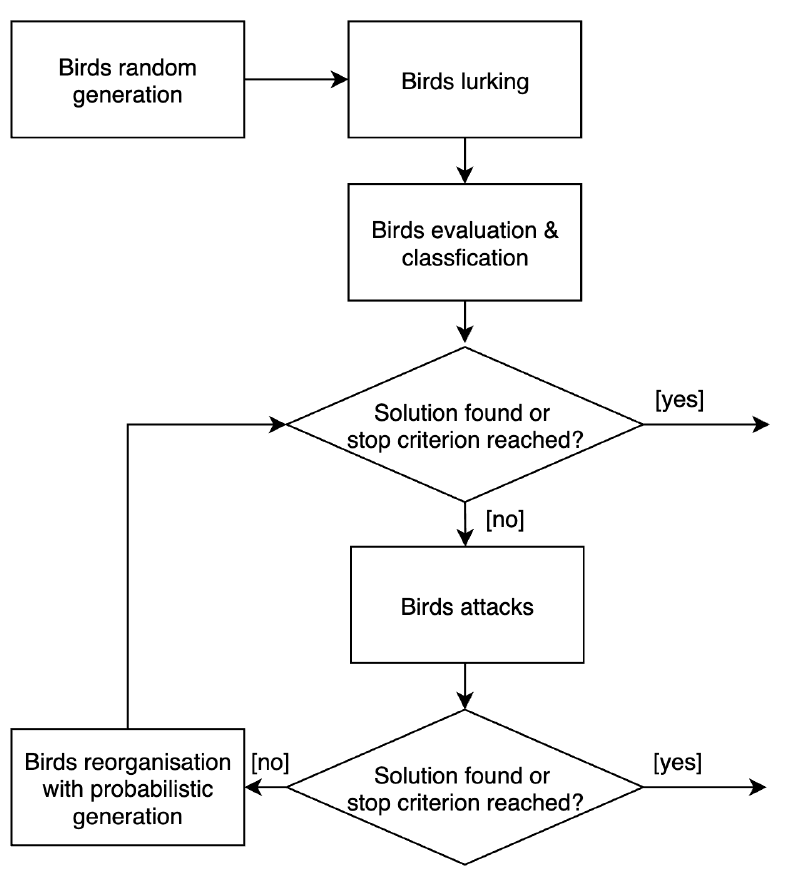
Figure 5. The different steps of the HBIA optimization